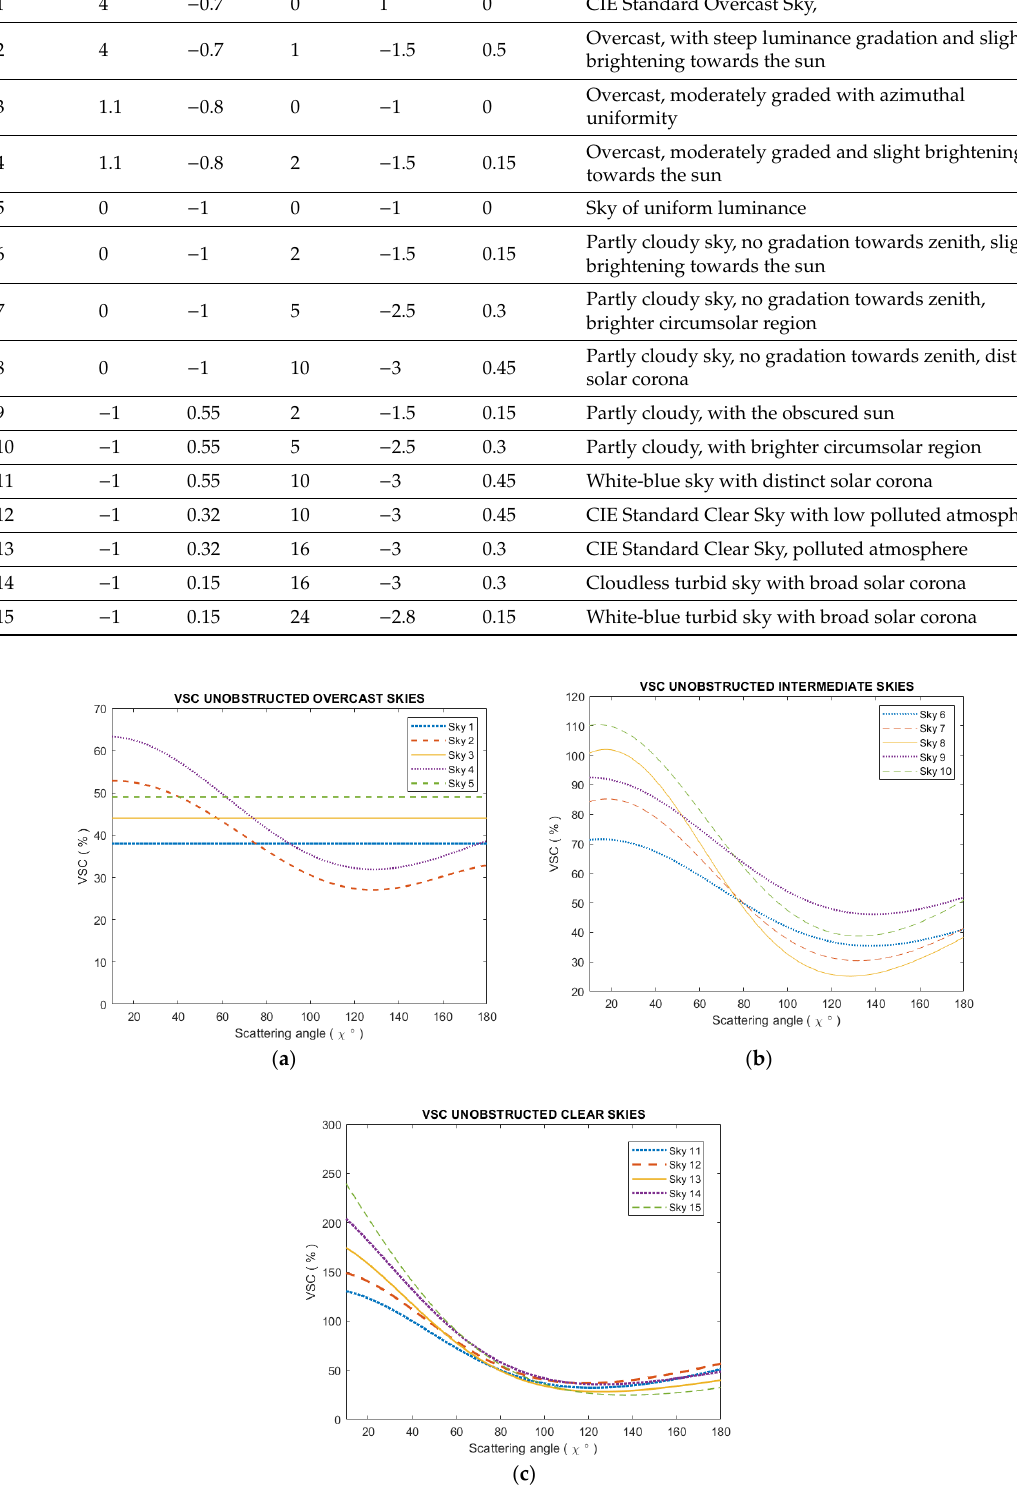
Figure 4. Vertical Sky Component (VSC) values for the different CIE sky types as a function of the scattering angle, 𝜒: ( a ) CIE standard sky types 1–5, ( b ) CIE standard sky types 6–10, ( c ) CIE standard sky types 11–15.